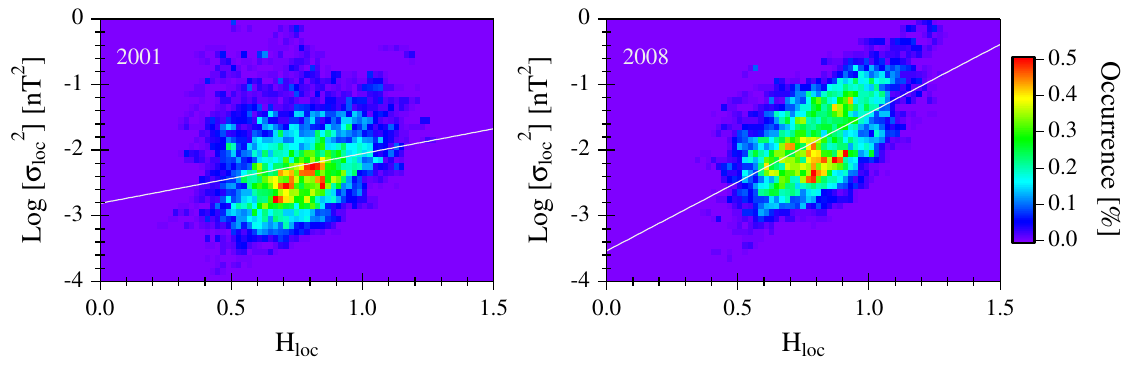
Fig. 13. The occurrence plot of the dependence of the local Hurst exponent H loc , computed by DMA technique, on the corresponding local variance σ 2 loc for the year 2001 (left panel) and the year 2008 (right panel), respectively. The solid white line is a linear fit of the corresponding scatter plot, denoting a positive correlation between log 10 [ σ 2 loc ] and H loc . Anyway, the significance of this positive correlation is more relevant for 2008 ( r ∼ 0 . 57 ) than 2001 ( r ∼ 0 . 21 ).